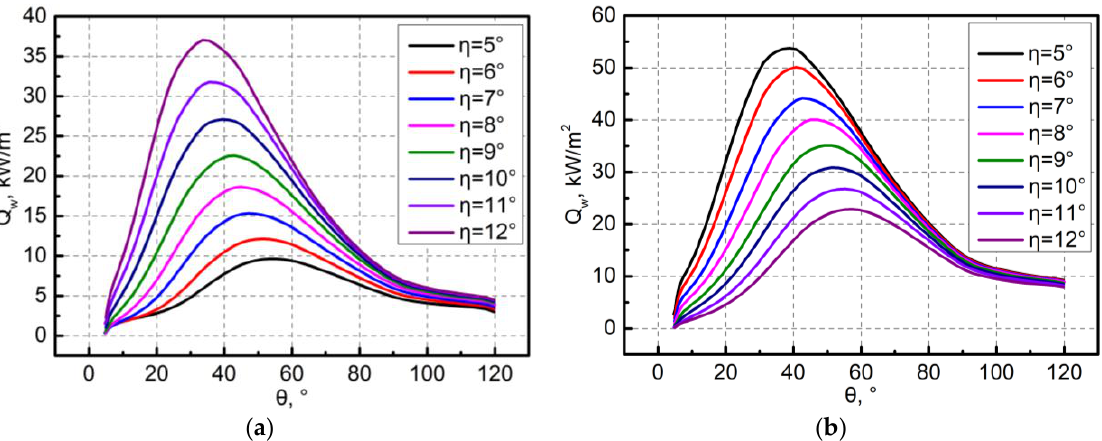
Figure 10. Heat flux distribution of nose cone at different installation angles: ( a ) leeward; ( b ) windward.